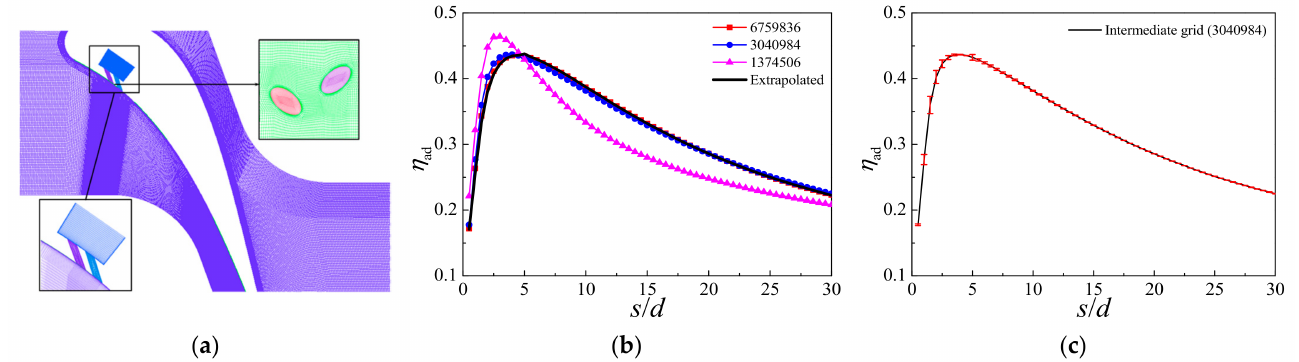
Figure 4. Representative meshes and grid independence test. ( a ) computational meshes, ( b ) adia- batic film cooling effectiveness along the centerline, ( c ) intermediate grid solution with discretization error bars.